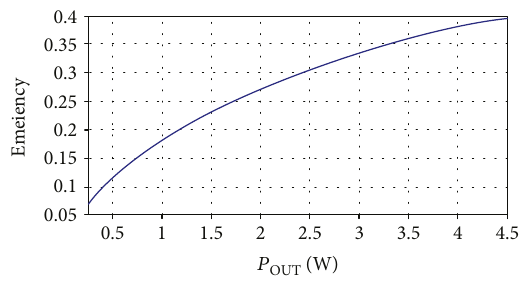
Figure 12: E ffi ciency of PA (SZM-2166Z).